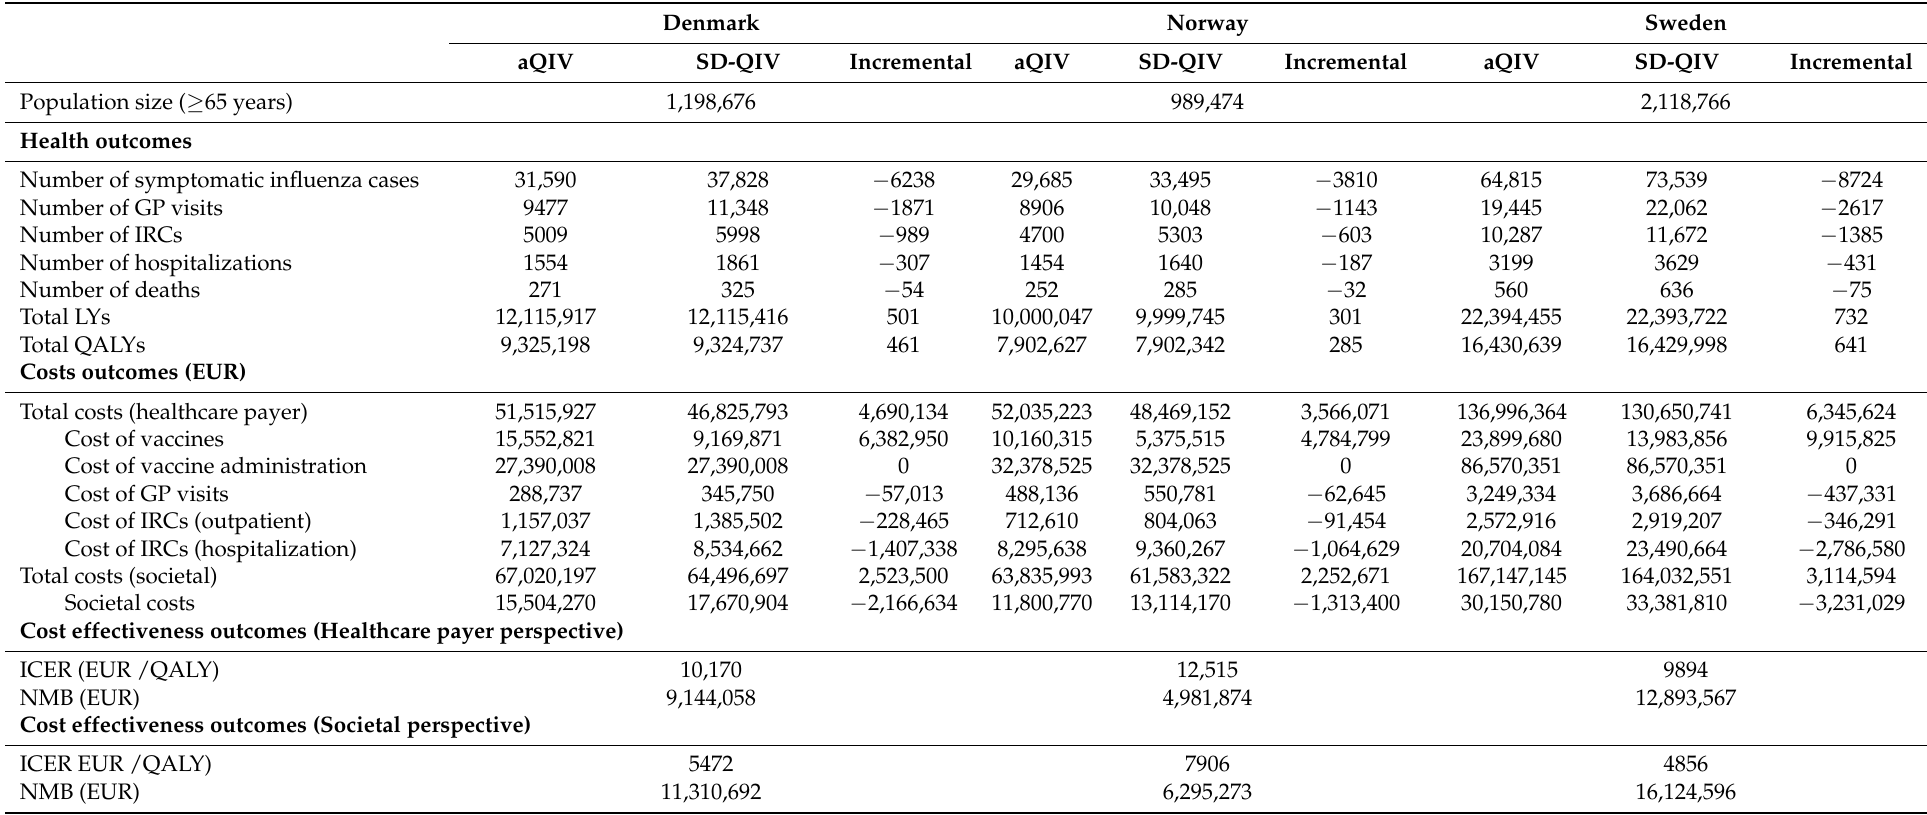
Table 4. Model results (aQIV vs.